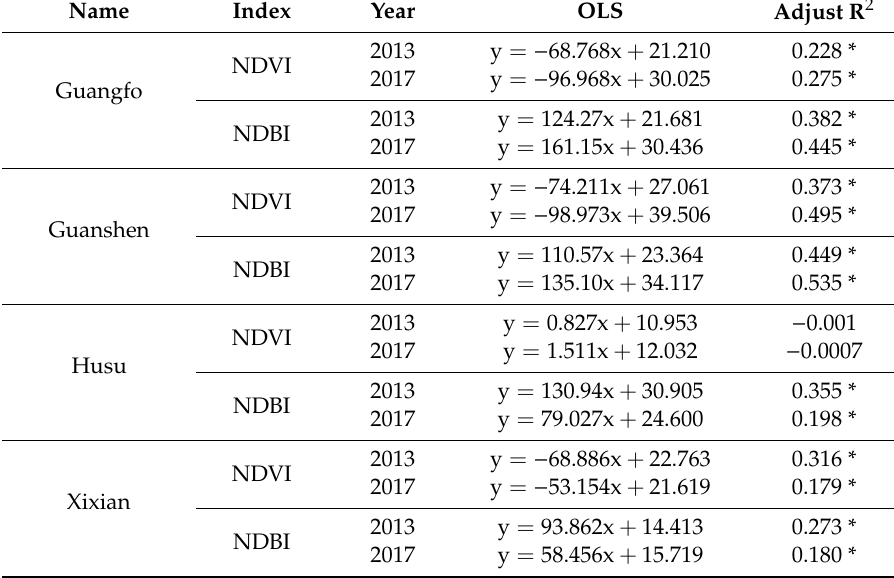
Table 4. The Operational Linescan System (OLS) analysis results of the Normalized Di ff erence Vegetation Index (NDVI), the Normalized Di ff erence Building Index (NDBI), and VIIRS Cloud Mask product (VCM) in four integrated